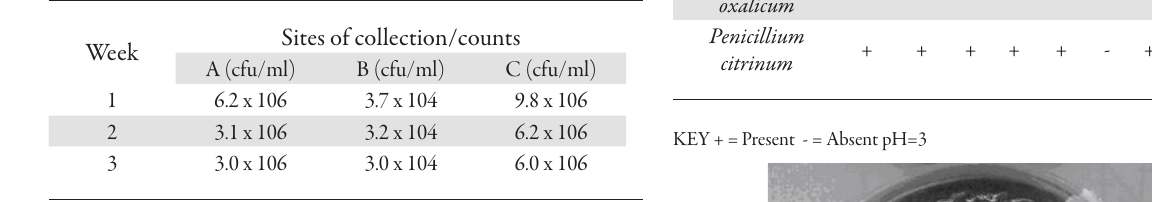
Tab. 1. Bacterial profile of Sugarcane Bagasse dumping sites